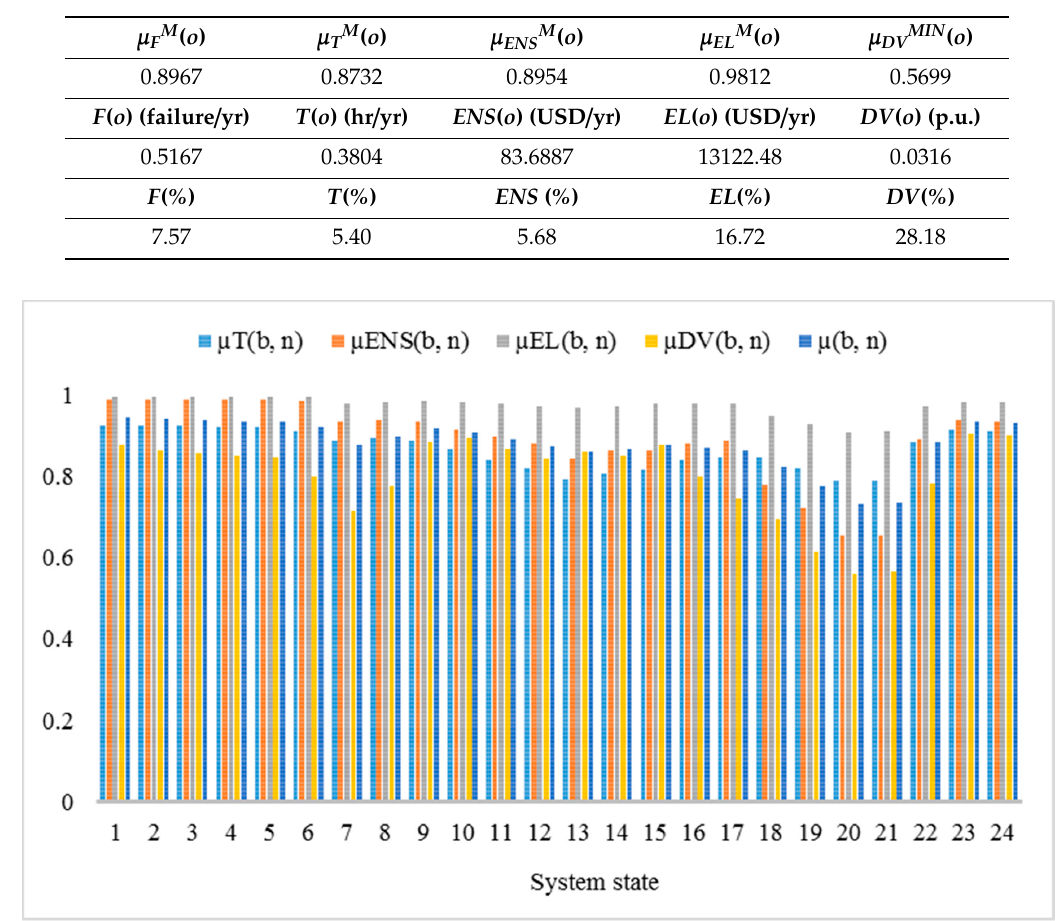
Table 9. Mean / minimum values of objectives after NR.